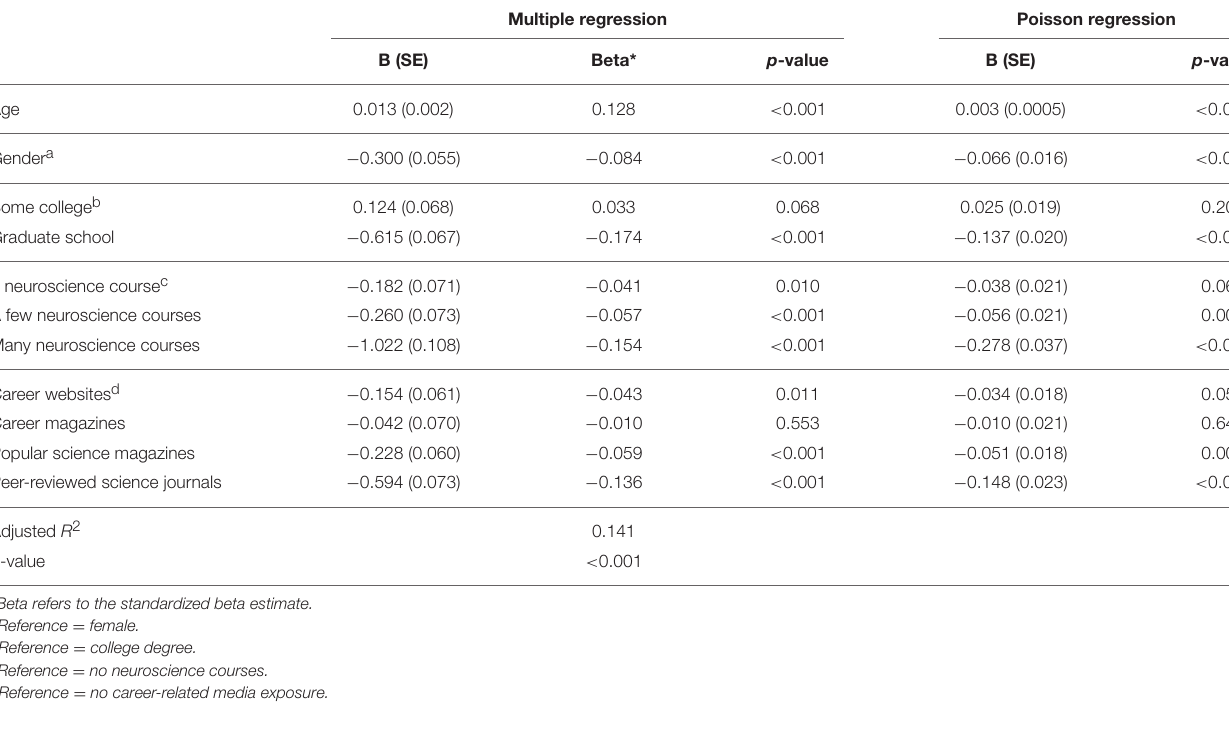
TABLE 7 | Regression results predicting neuromyths (i.e., % of items incorrect from neuromyths factor) in the full sample ( N = 3,877).